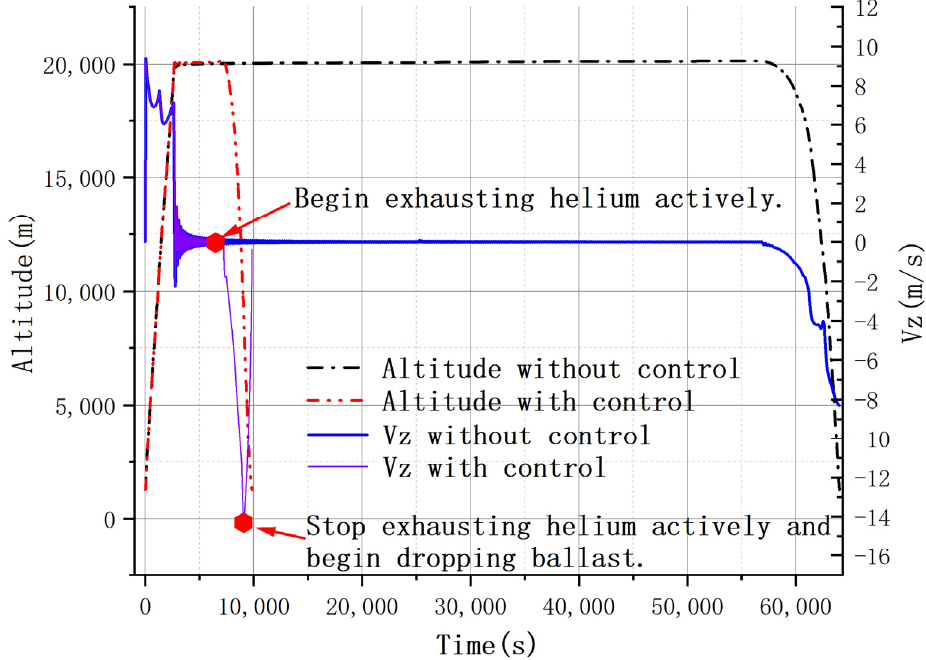
Figure 19. Simulation results of Mission D: balloon system’s change in vertical speed vs. time and change in altitude vs. time while the control strategies are applied (or not).